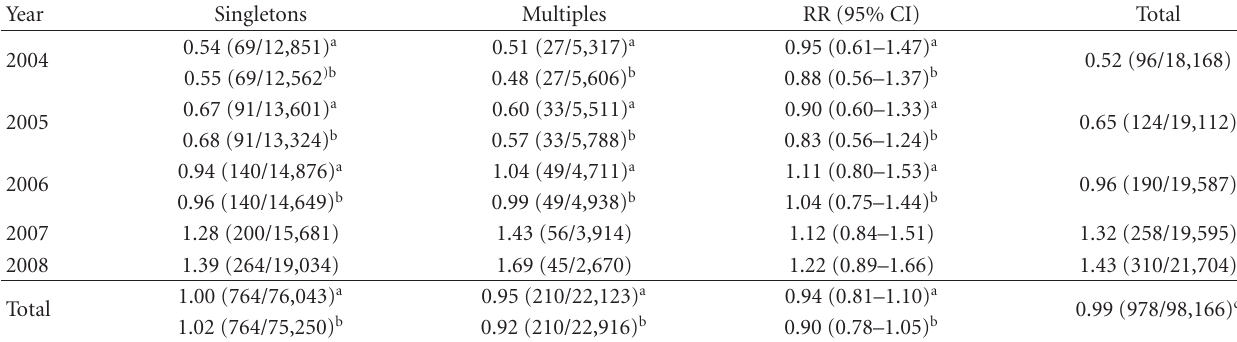
Table 3: Crude percentage of birth defects in ART live-born babies according to